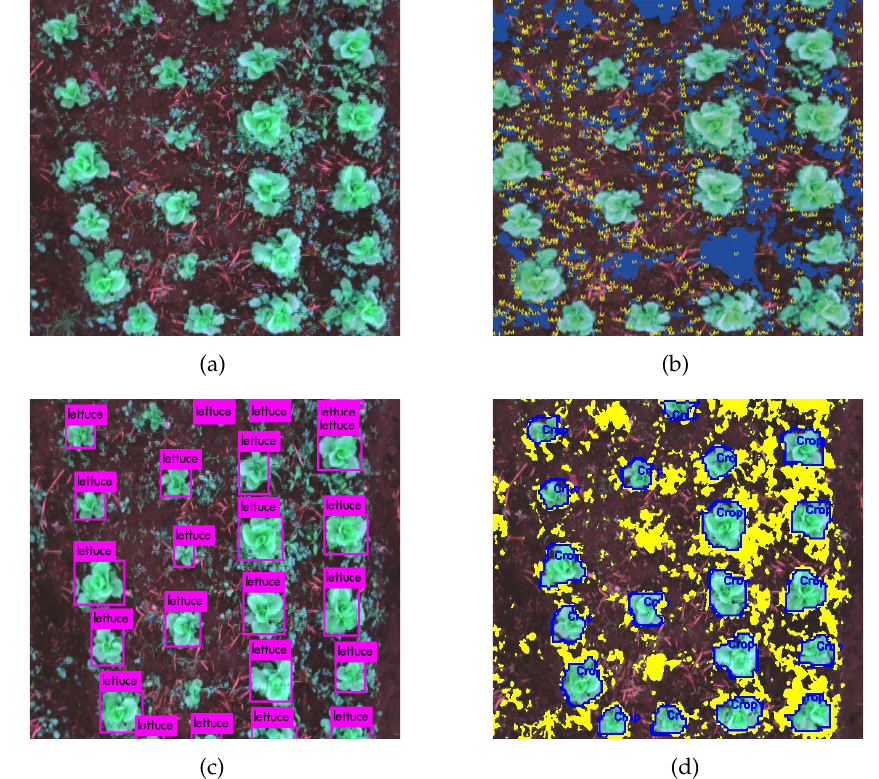
Figure 6. Resulting images: (a) Preprocessed image. (b) Method 1. (c) Method 2. (d) Method 3. Figure 4. Resulting images: ( a ) Preprocessed image. ( b ) Method 1. ( c ) Method 2. ( d ) Method